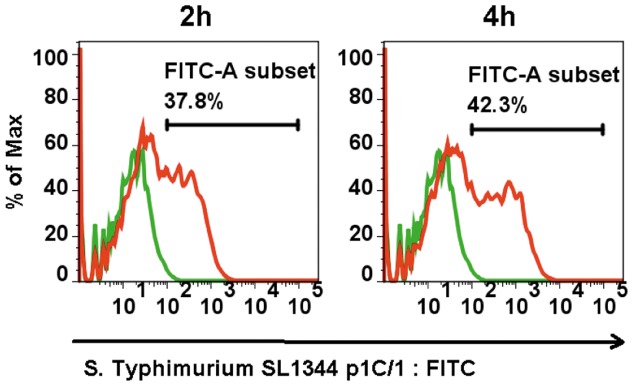
The invasion assay was also evaluated by Flow Cytometry.The ability of S. Typhimurium SL1344(p1C/1), able to express GFP once inside the host cell, to invade ESDCs was measured by monitoring the GFP expression using FACS analysis. Cells were analyzed for GFP expressing bacteria at time 2 and 4 hours post-infection. The horizontal bar in each histogram represents the percentage of fluorescent positive cells on 10.000 events. FITC subset in non infected cells is <1%. These data are representative of at least 3 independent experiments.